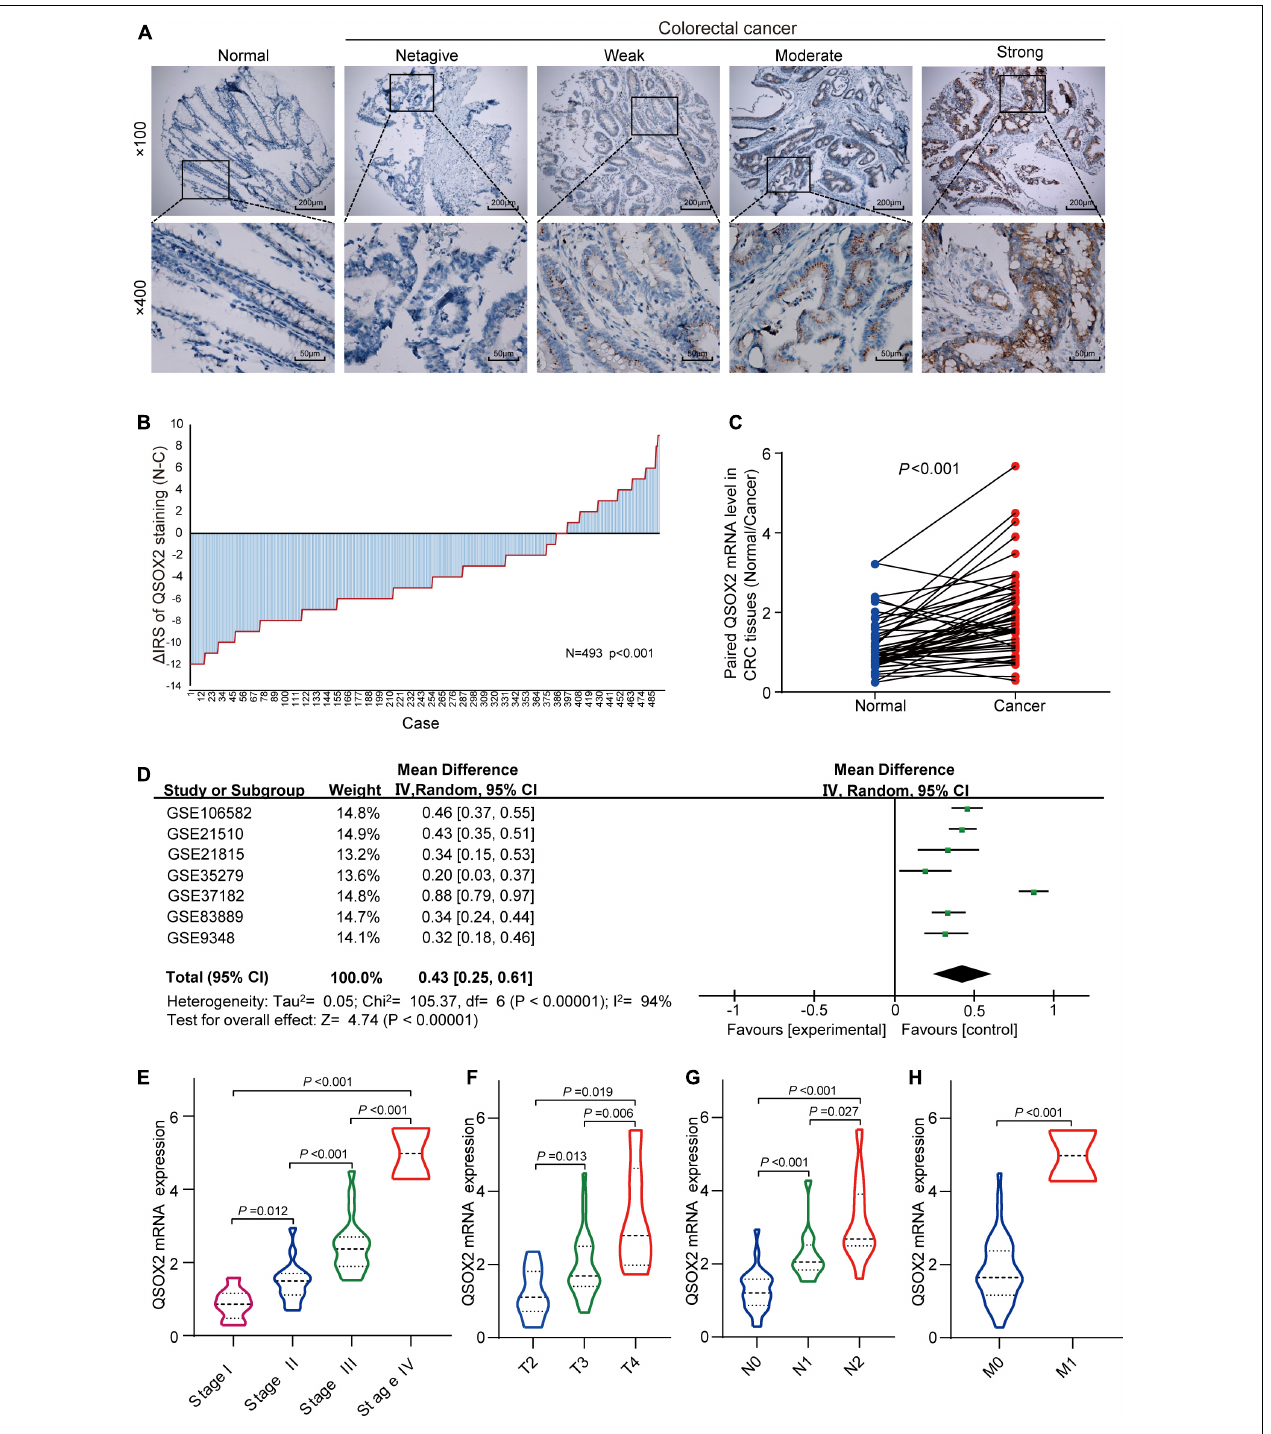
FIGURE 2 | Expression of QSOX2 is upregulated in clinical CRC patient specimens and GEO microarrays. (A) Representative images of QSOX2 expression in the tumor microarrays (TMAs) using immunohistochemistry (IHC) staining. (B) QSOX2 protein expression was significantly upregulated in cancerous tissues ( p < 0.001, the paired Wilcoxon test). Note: N, paired adjacent non-tumor tissues (NTTs); C, CRC tissues. (C) The mRNA expression of QSOX2 in 50 cancerous tissues and corresponding non-tumor tissues were detected by quantitative real-time PCR (qRT-PCR) ( p < 0.001). (D) Forest plot of QSOX2 expression data from GEO microarrays. Note: GEO, Gene Expression Omnibus; SMD, standard mean difference; CI, confidence interval. (E–H) Violin plot evaluating QSOX2 mRNA expression in different groups classified according to clinical characteristics. (E) TNM stage. (F) Depth of invasion. (G) Lymph node metastasis. (H) Distant metastasis.